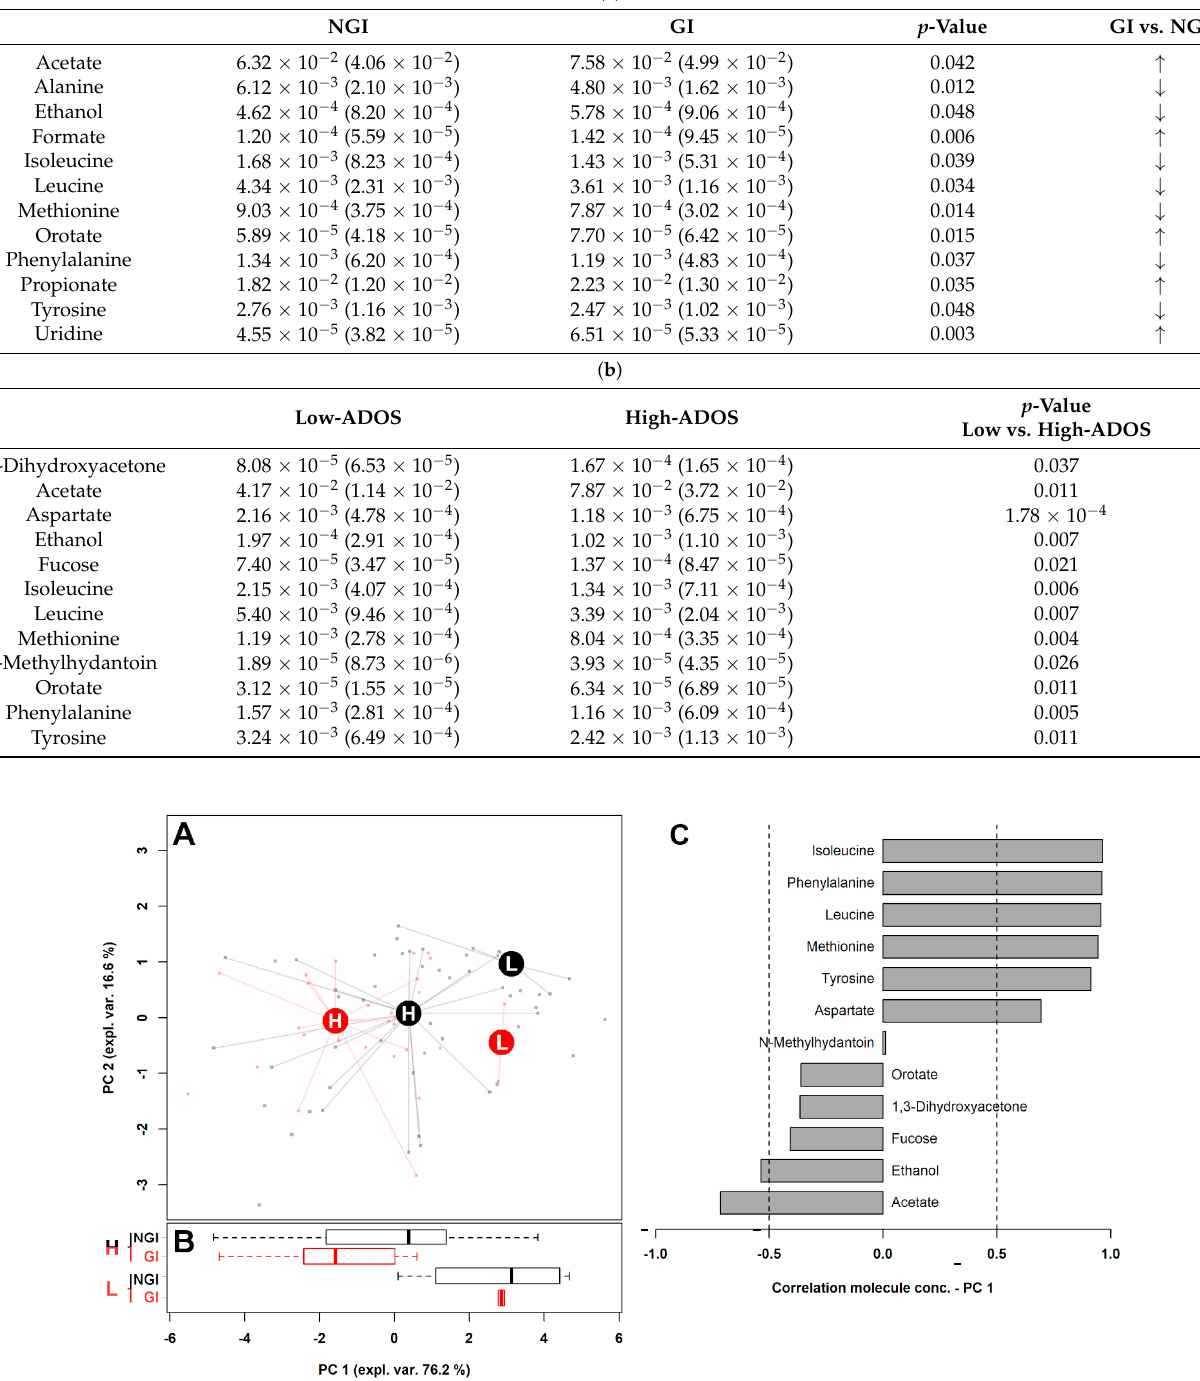
Figure 1. rPCA model calculated on fecal samples metabolomics of molecules reported in Table 1b distinguishing children within low-ADOS (L) and high-ADOS (H) groups. ( A ) The score plot reports the samples joined with lines to their median values, represented with big filled circles. Children without (NGI) and with gastrointestinal symptoms (GI)are evidenced with black or red colors, respectively. ( B ) Boxplot summarizing the position of the groups along with PC 1. ( C ) Correlation plot reporting the correlation between each substance’s importance over PC 1 and its concentration. Gray bars highlight significant correlations ( p <